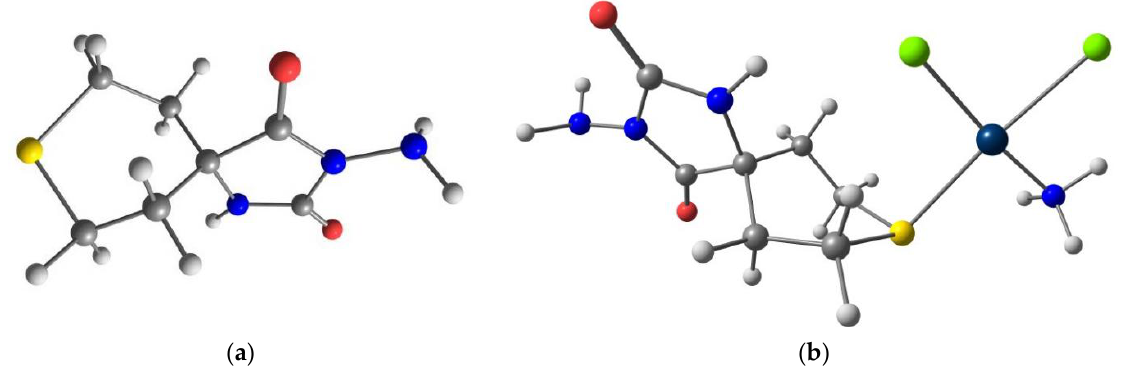
Figure 2. Optimized structures of ligand 1 ( a ) and complex 2 ( b